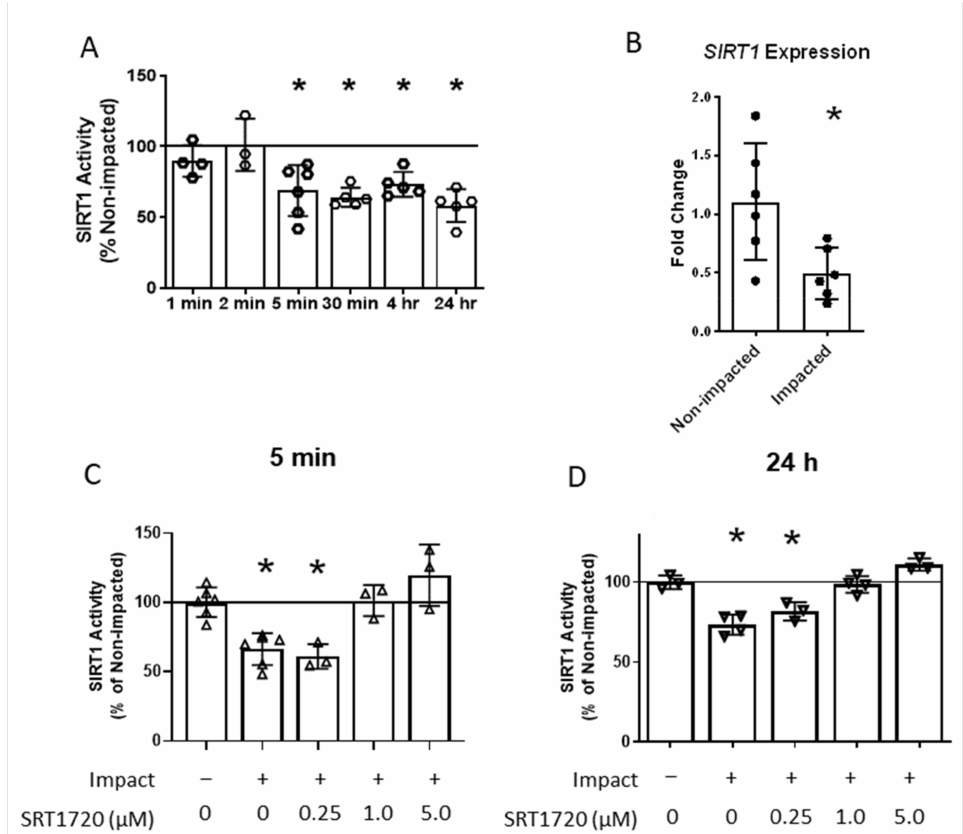
Figure 2. SIRT1 enzyme activity decreases with cartilage impact and is blocked by SIRT1 activator SRT1720. ( A ) SIRT1 enzyme activity at different time points post impact. * indicates statistically significant difference in SIRT1 activity compared to non-impacted cartilage samples at the same time point, uncorrected p < 0.05 ( n = 3 to 5). ( B ) SIRT1 mRNA expression 24 h post impact relative to 18s expression. * indicates significant difference from non-impacted group, p < 0.05 ( n = 3). ( C ) SIRT1 enzyme activity 5 min post impact with SRT1720 treatment. * indicates significant difference from non-impacted, untreated controls, p < 0.05 ( n = 5 or 6). ( D ) SIRT1 enzyme activity 24 h post impact with SRT1720 treatment. * indicates significant difference from non-impacted, untreated controls, p < 0.05 ( n = 3 or